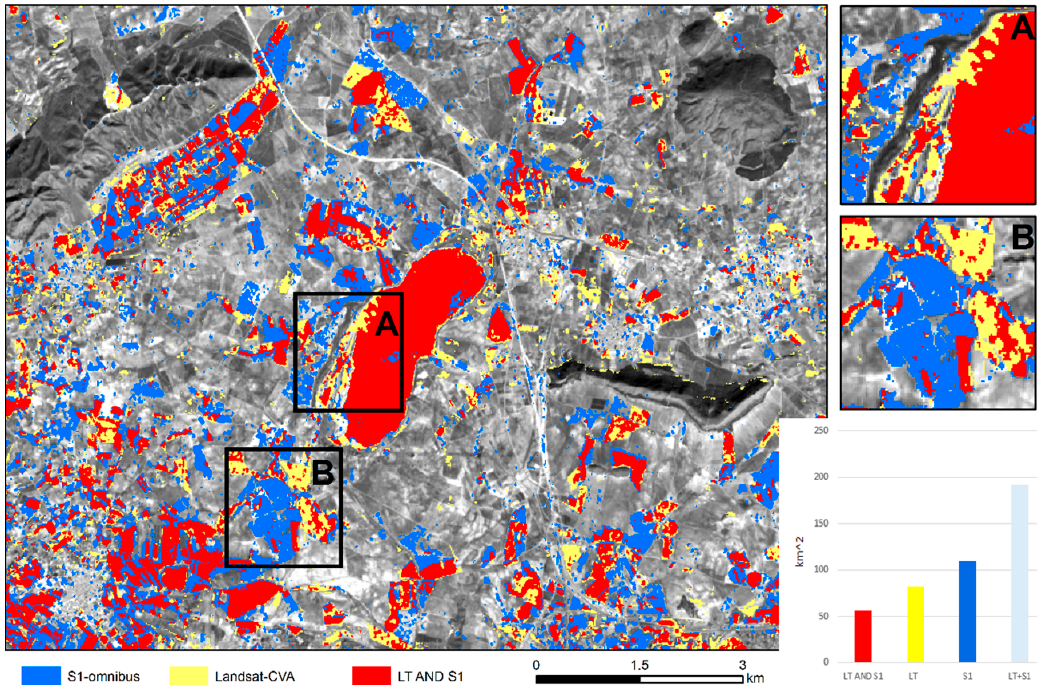
Figure 6. Changes detected by S1-omnibus (blue), by Landsat-CVA (yellow) and by both methods (red). Subsets A and B show a closer look at the two areas of change indicated in the main image. In chart, light blue color represents the area detected as change by either method.